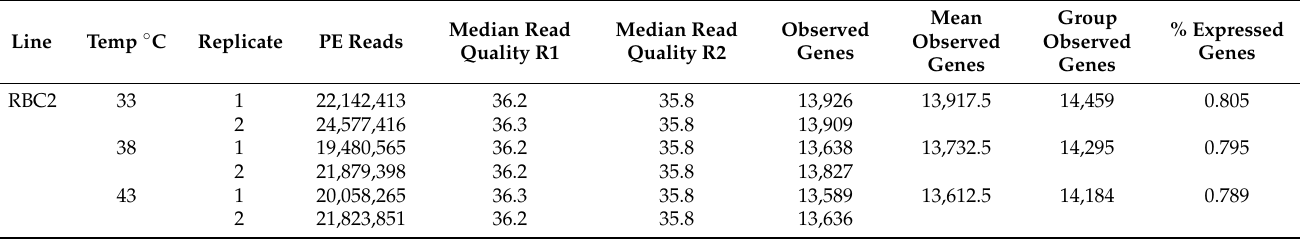
Table 1. Summary of differentiation RNAseq